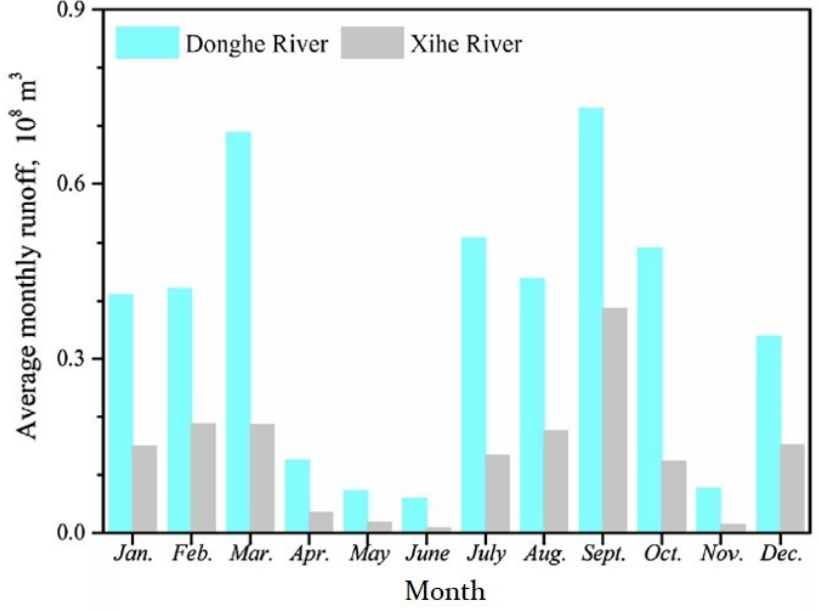
Figure 3. Average monthly runoff of the Donghe and Xihe Rivers measured at the Langxinshan hydrological station (Figure 1) from 1988 to 2017.